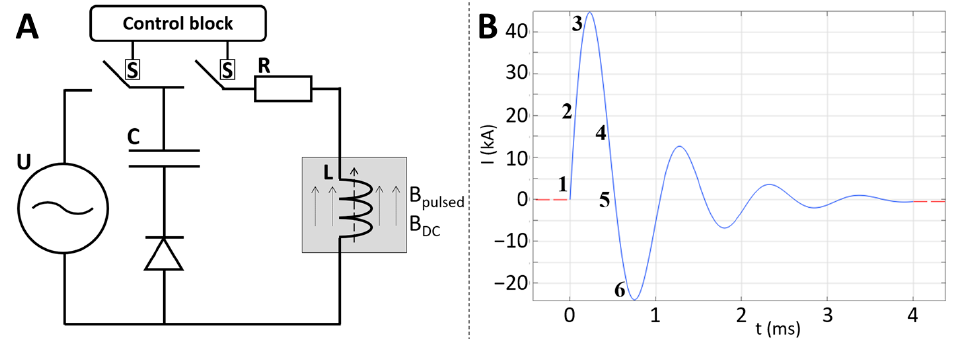
Figure 2. ( A ) Electrical scheme of the pulsed magnetic field source. ( B ) Measured pulse current in the coil.